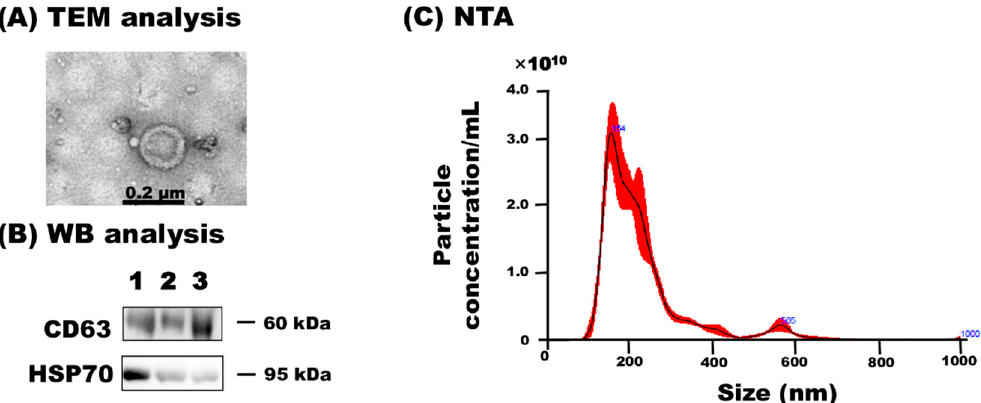
Figure 1. Characterization of milk sEVs. ( A ) TEM detected bilayer spherical shape sEVs in milk (Scale bar shows 0.2 µm). ( B ) WB analysis successfully detected milk sEV-surface-marker protein CD63 and internal protein HSP70 using antibodies, anti-CD63 (SC-31214, Santa Cruz Biotechnology), and anti–HSP70 (N27F3-4, Enzo Life Science), respectively. ( C ) The size distribution of milk sEVs as determined by NTA. A representative data from cow 2 is shown (mean peak size < 0.2 µm in diameter). TEM, transmission electron microscopy; WB, western blot; NTA, nanoparticle tracking analysis.